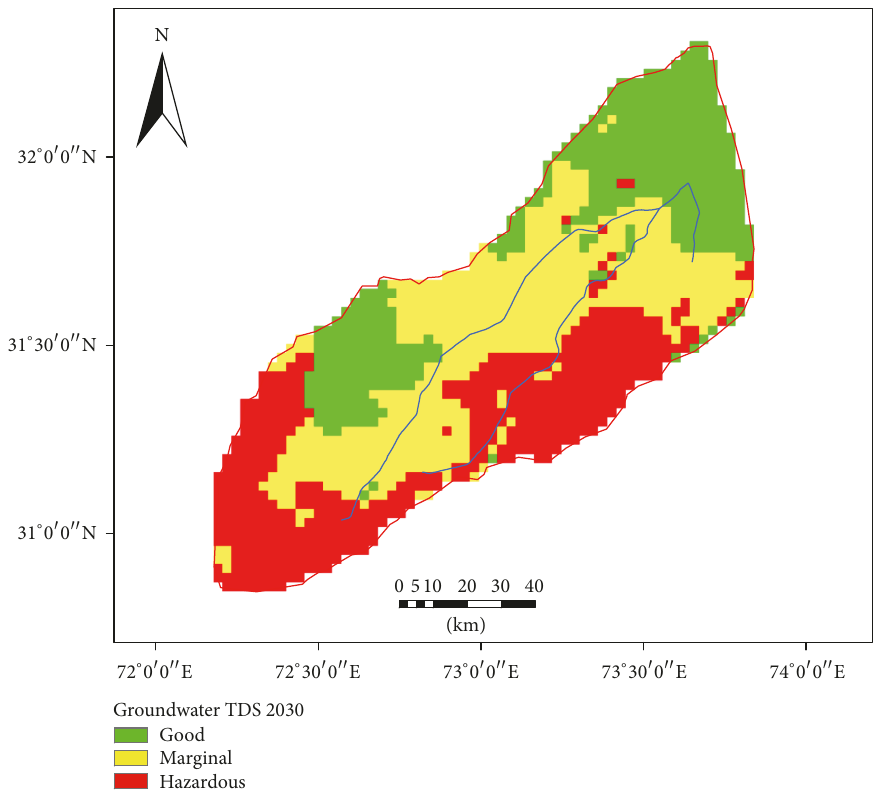
Figure 12: Predicted groundwater quality in year 2030 (Scenario